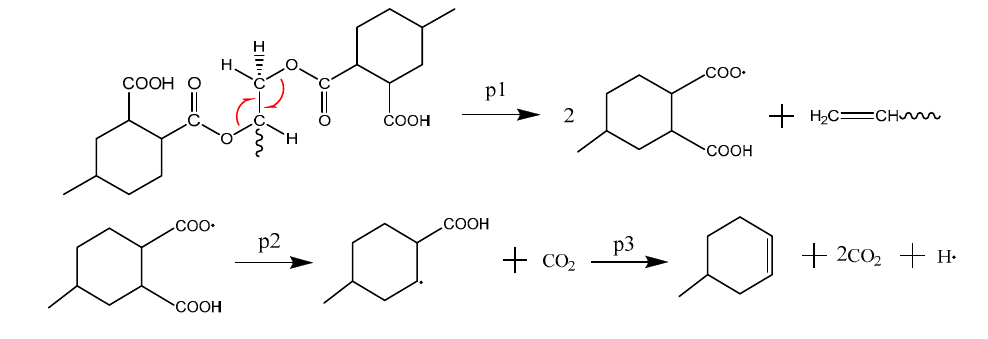
Figure 7. The main mechanism of CO 2 formation.